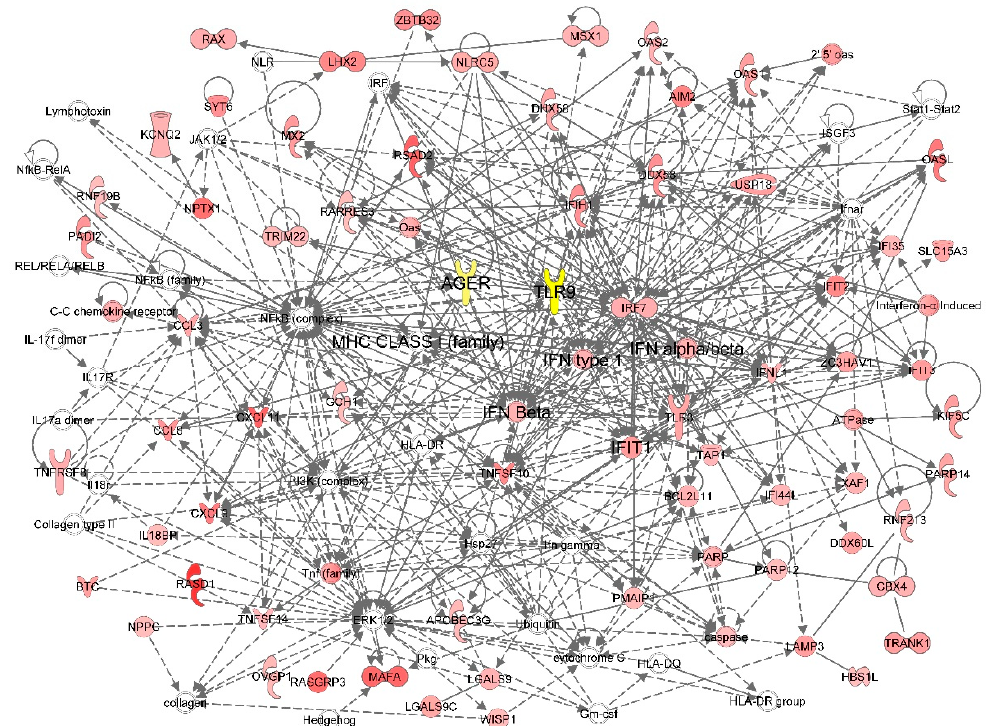
Figure 5. Network analysis of RAGE ( AGER ) and HSV-1 infection-induced transcriptional responses of HCEn cells. Functional analysis was conducted to determine the associations of the HSV-1 infection-induced genes with biological functions. A set of 430 infection-induced genes (fold induction > 4) were analyzed for network generation of biological functions. The 3 highest significant networks ( p < 1 × 10 − 32 ) are summarized as merged networks. RAGE ( AGER ) and TLR9 were significantly associated with type I interferon responses.